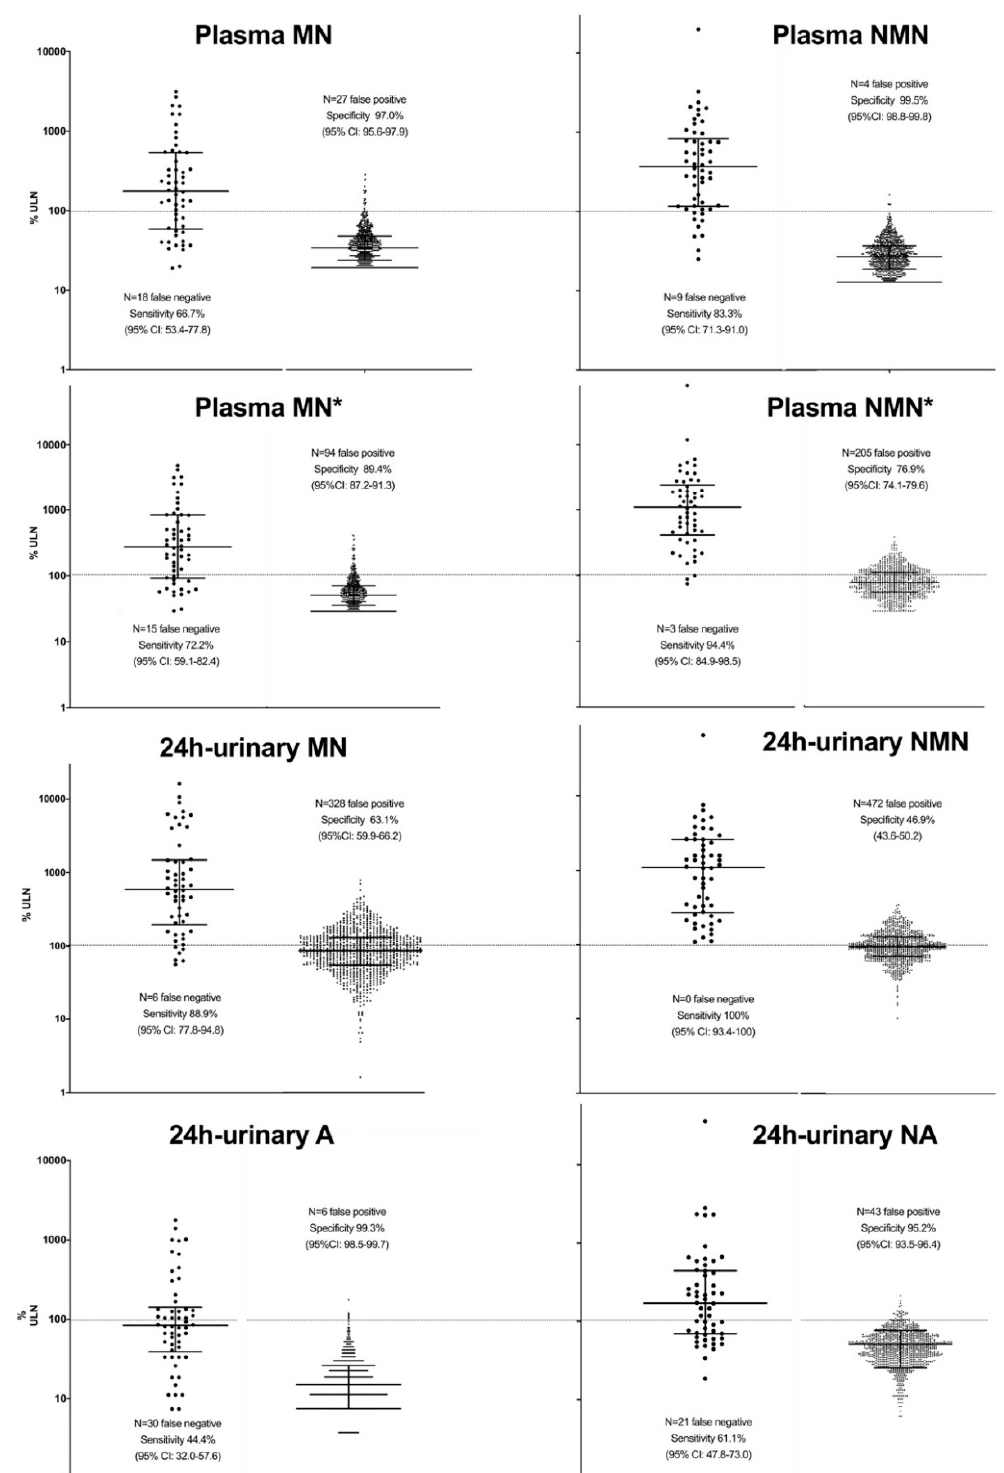
Figure 2. Sensitivities and specificities of single parameters with all ULN. Data are presented for 54 patients (left columns), and for 889 individuals without (right columns) PPGL, respectively. Concentrations are expressed as percentages of the respective ULN (dashed line). Lines within the graph depict medians and inter-quartile ranges. The asterisks (*) denote P-MN and P-NMN with the corrected ULN as proposed recently [17]. Please note the logarithmic scale!